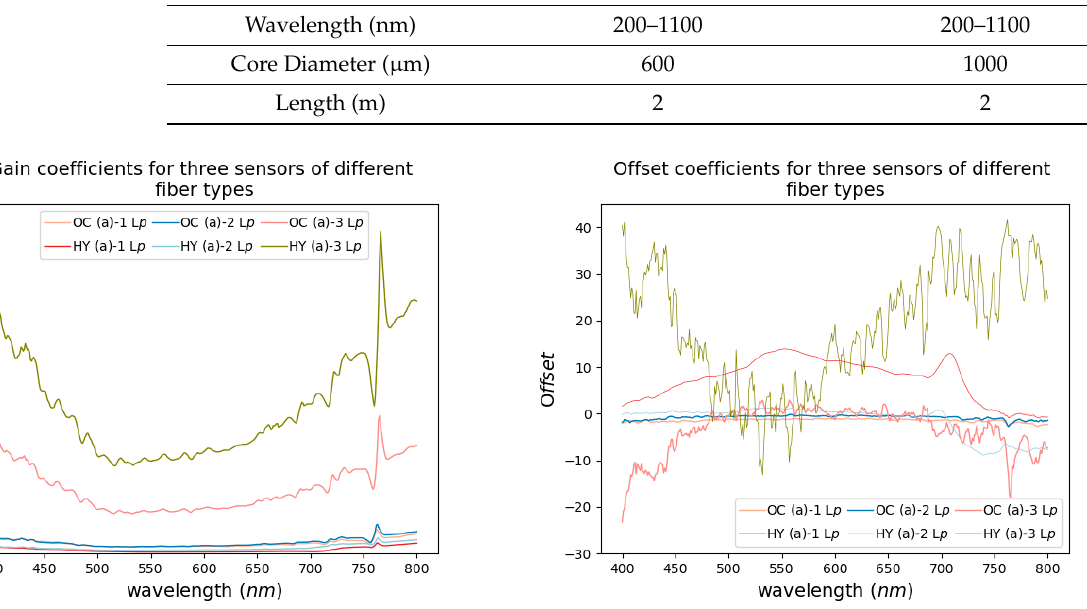
Table 2. Parameter table of different fiber types.